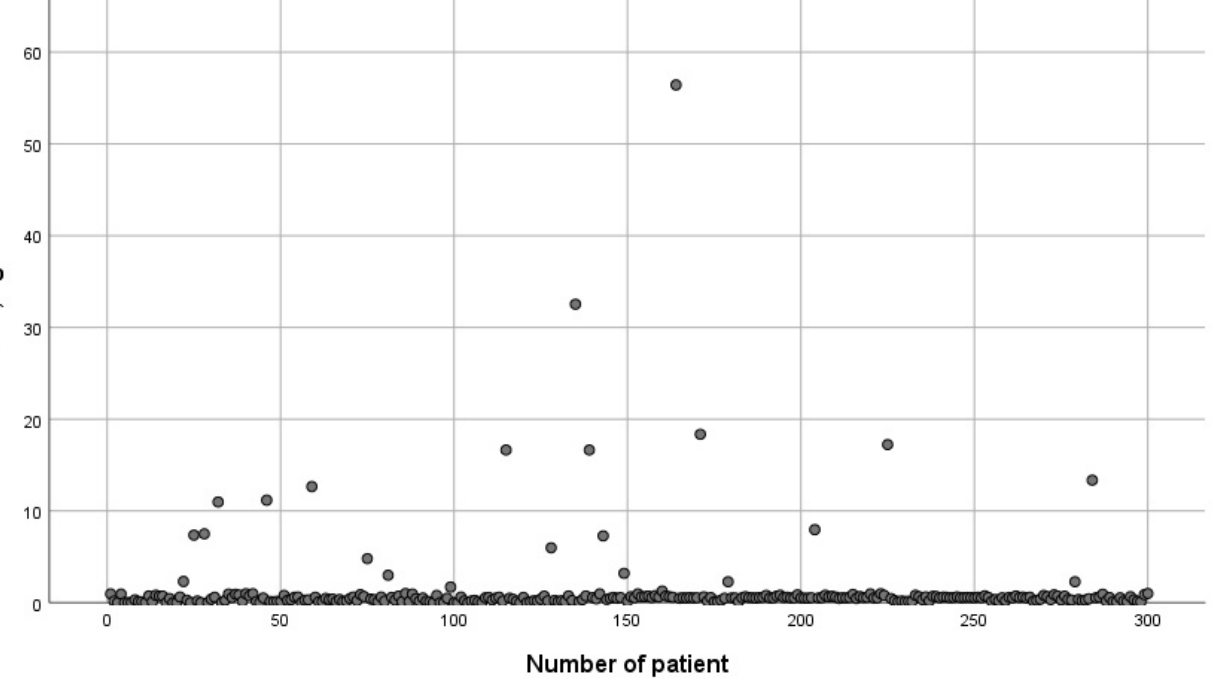
Figure 1. The distribution of BPA concentration in the blood.